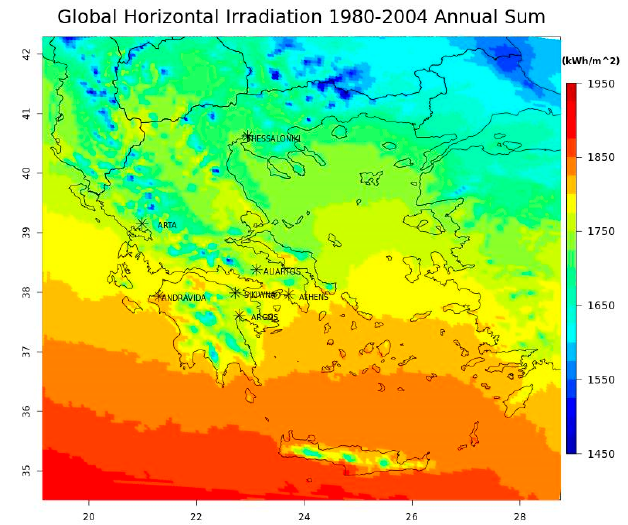
Figure 4. Mean annual GHI values calculated from WRF simulations under the historical scenario (1980–2004), and the locations of the selected meteorological stations, during the process of the qualitative comparison.